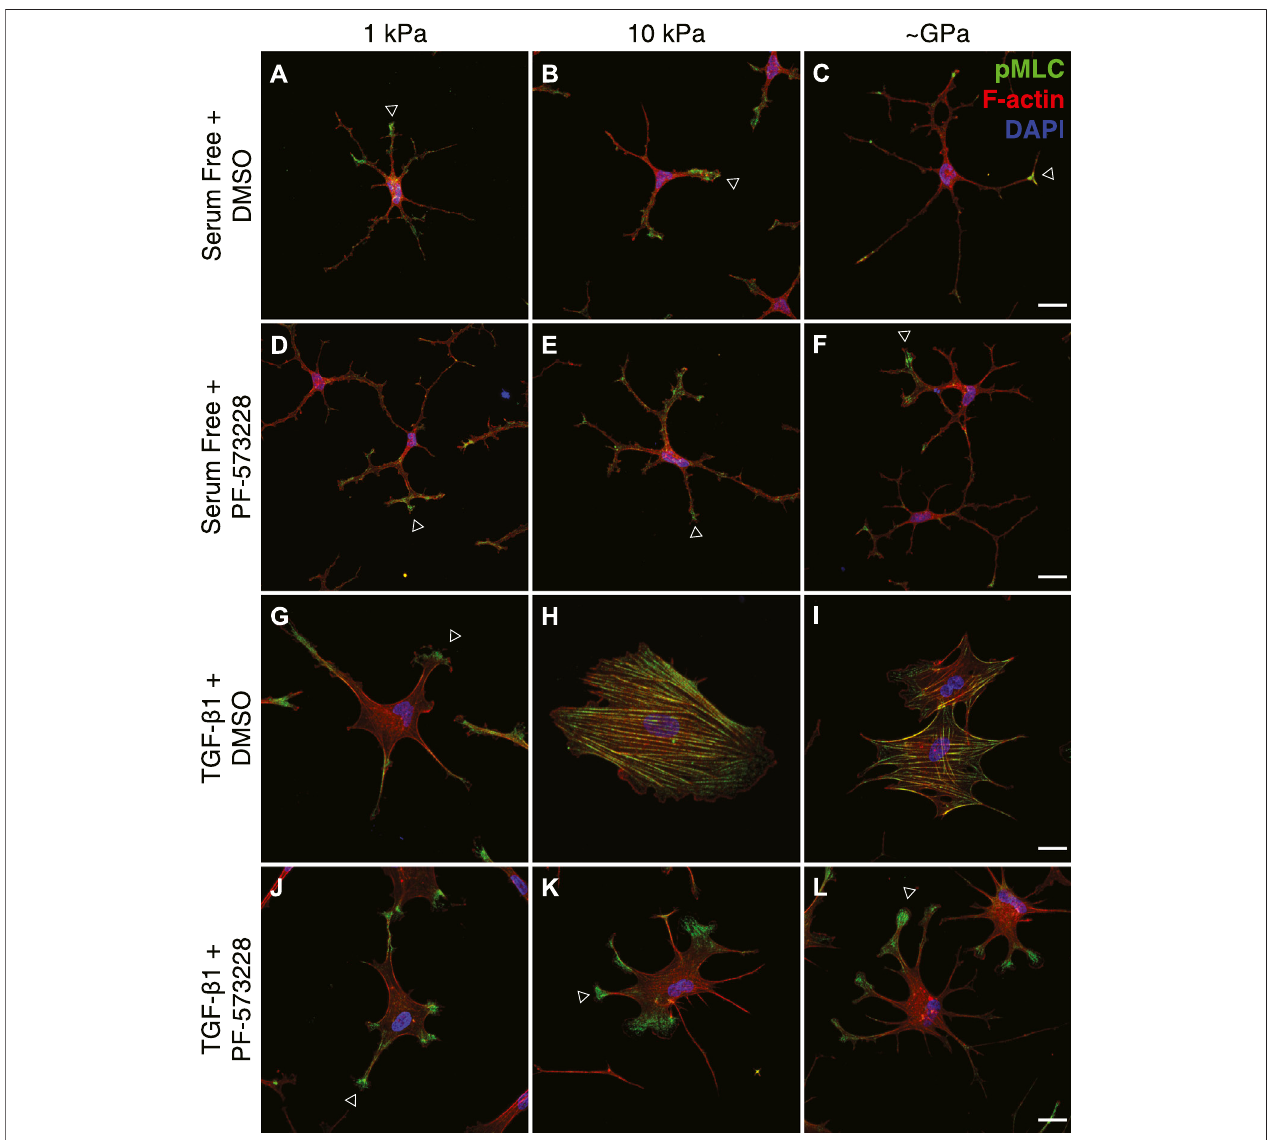
FIGURE 5 | FAK inhibition disrupts stiffness-dependent differences in the subcellular distribution of actomyosin contractility. (A – L) Characteristic confocal fl uorescence images of cells cultured on either functionalized 1 kPa (A,D,G,J) or 10 kPa (B,E,H,K) PA substrata, or collagen-coated glass (C,F,I,L) coverslips. Cells were cultured for 5 days in either serum-free conditions (A – F) or in medium containing exogenous TGF- β 1 (G – L) , and in either the presence (D – F,J – L) or absence (A – C,G – I) of the FAK inhibitor, PF-573228. Cells were stained for phosphorylated myosin light chain immuno fl uorescence (pMLC; green), as well as F-actin (red) and DAPI (blue). Arrowheads indicate cellular processes with elevated levels of pMLC staining at the tips. Scale bars, 25 μ m.